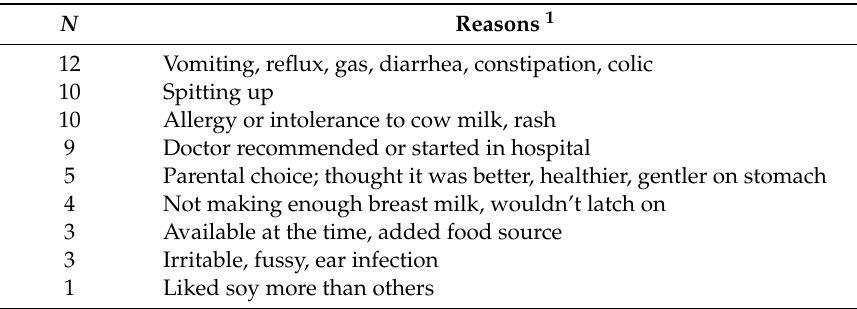
Table 7. Reasons children with FXS were fed soy-based formulas.